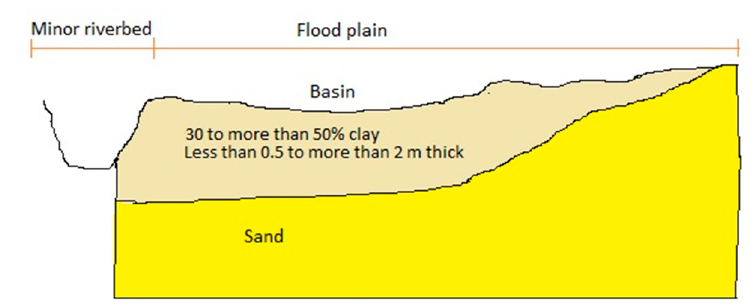
Figure 2. Profile of a flood-recession farming basin.